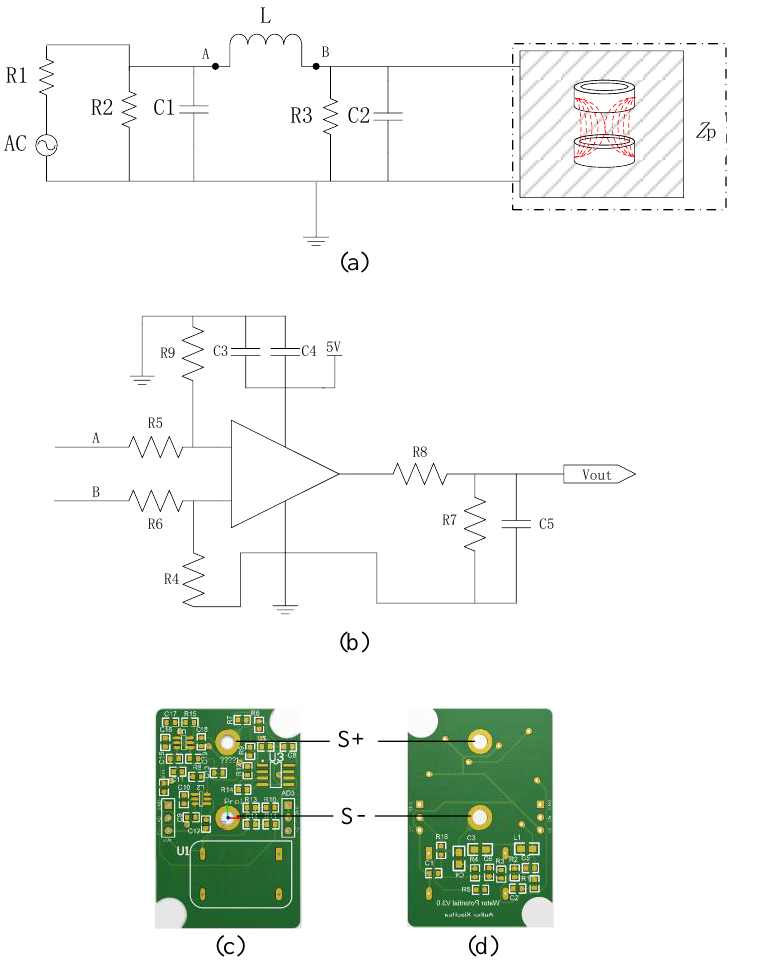
Figure 4. The impedance measurement circuit: ( a ) a schematic diagram of the impedance sensing circuit; ( b ) a schematic diagram of the signal amplification circuit; ( c ) the front of the PCB; ( d ) the back of the PCB. S+ and S − are the link fixing holes for the positive and negative terminals of the probe, respectively.